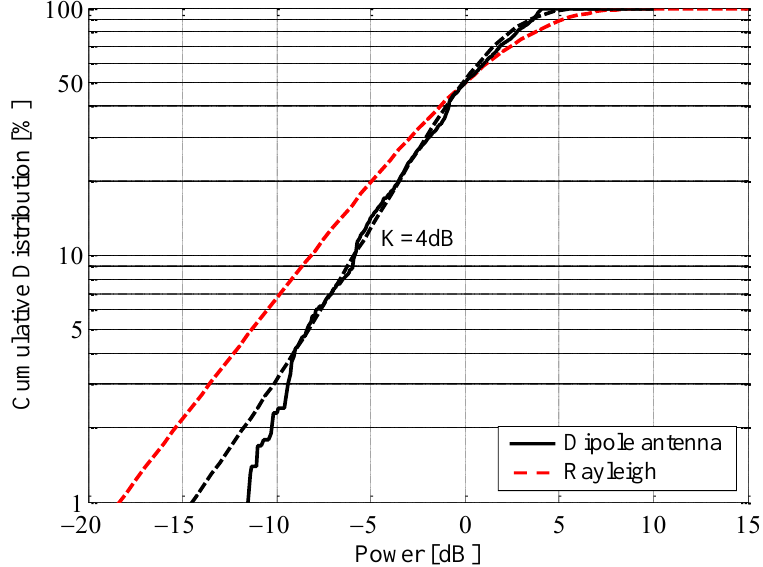
Figure 24. CDF characteristics of the received power in short-term fading.